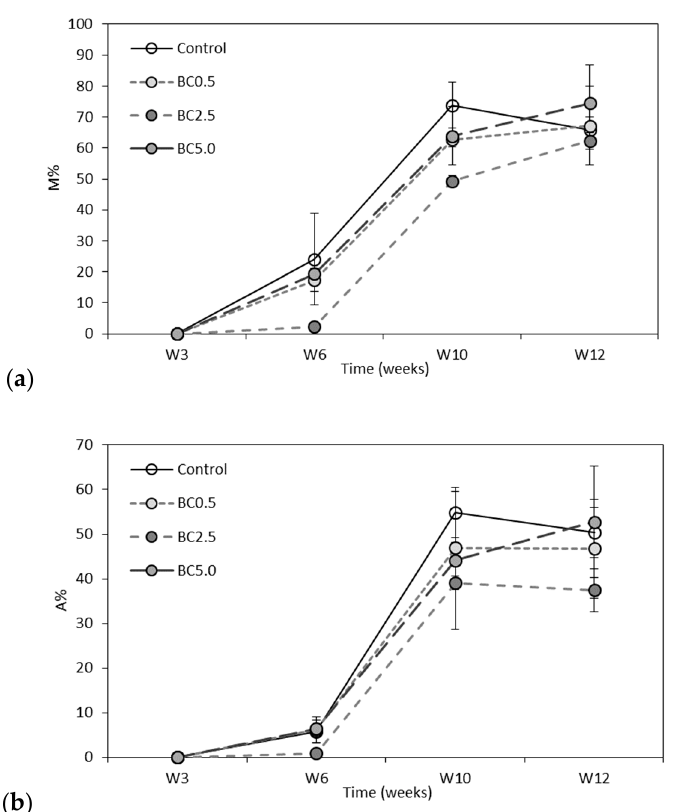
Figure 5. Intensity of ( a ) arbuscular mycorrhizal fungi (AMF) colonization (M%) and ( b ) arbusculum richness of root system (A%) for the different treatments over time. BC0.5, BC2.5, and BC5.0 represent 0.5%, 2.5%, and 5.0% biochar amended soil, respectively. A close correlation was found between AMF colonization parameters ( r = 0.98. However, there was no correlation between easily-extractable glomalin-related soil protein (EEG-GRSP) content of the soils and AMF root colonization (Gl_1 mm: r = 0.08; Gl_2 mm: r = -0.22)). The EEG-GRSP concentration in <1 mm soil fraction was not affected by the age of plants, but it was affected by the doses of biochar. Our results showed significant differences between BC2.5 and BC5.0 compared to control or BC0.5, while between weeks no significant differences were observed for the treatments. EEG-GRSP of 1 − 2 mm soil fraction significantly decreased in the soil of the harvested plants (W12; Figure 6).